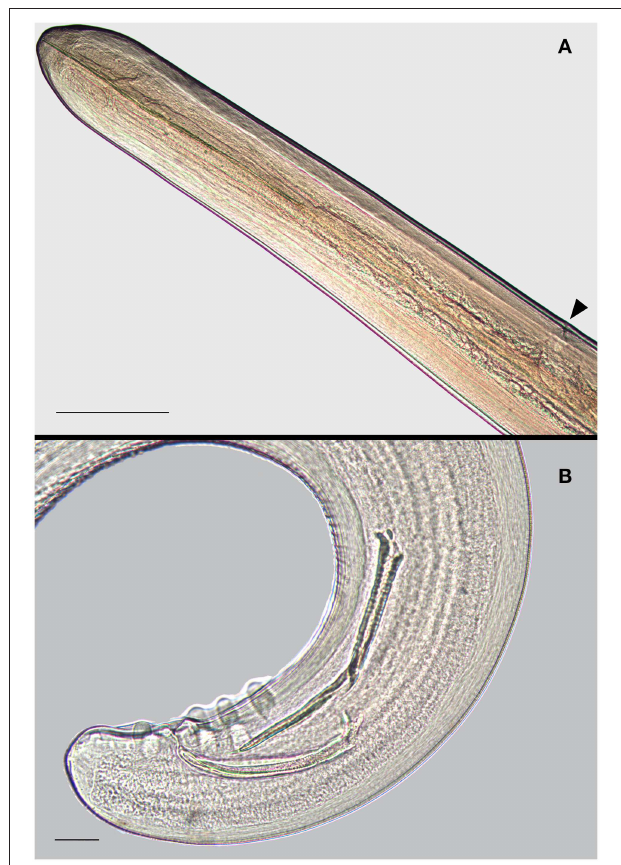
FIGURE 2 | Adult Dirofilaria immitis . Anterior extremity of the female (A) showing the genital pore (arrowhead); bar = 500 µ m. Caudal extremity of the male (B) showing the spicules and large ventro-lateral papillae; bar = 50 µ